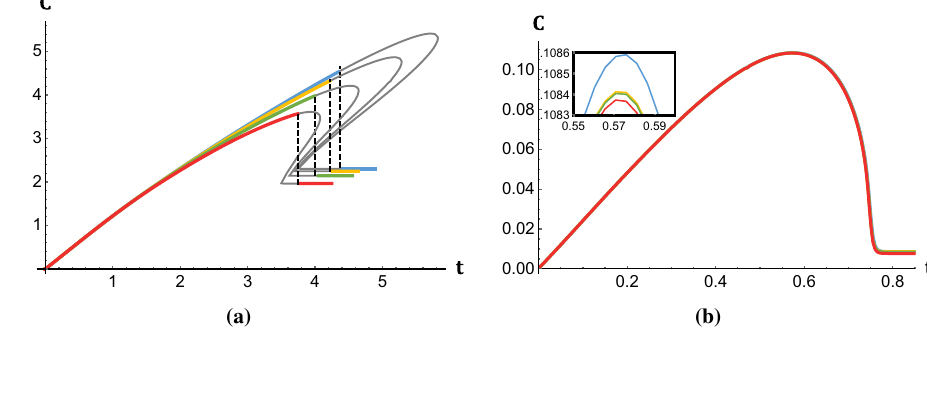
Q = 0 . 65, l = 5. While the right plot is for the evolution of HEE with various values of Q , where the blue, yellow and green lines correspond to Q = 0 . 2, 0 . 4, 0 . 65, respectively